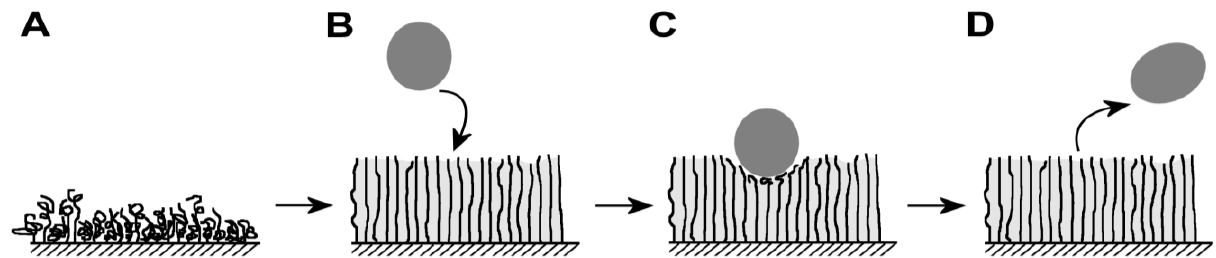
Figure 2. Polymer brush surfaces: The non-hydrated polymers are randomly packed on the surface ( A ) and will create a tightly packed highly hydrated brush in aqueous environment ( B ). Proteins or microbes encountering the brush surface will be repelled by steric hindrance due to the bound water in the brush and the elasticity of the polymer chains ( C , D